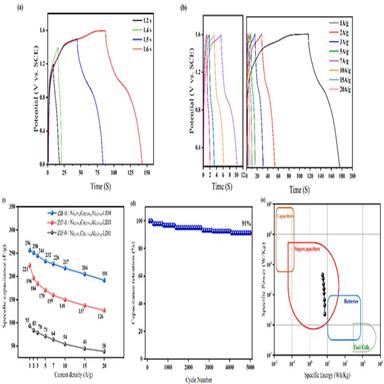
(a) GCD curves in different voltage ranges and current densities. (b) Charge-discharge curves of the ASC at various current densities. (c) Cycling life of the ASC device at 3 A/g after 5000 cycles. (d) Ragone plot of the ASC showing the relationship between energy density and power density.